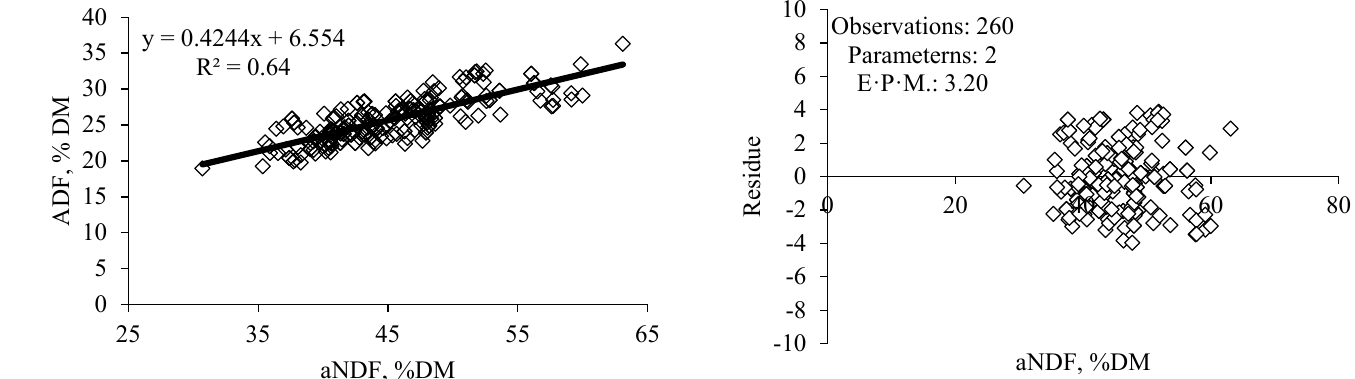
From the analysis of aNDF and ADF of the sampled silages ( n = 260), we defined an equation for predicting ADF from the aNDF content obtained, being: y = 0.4244x + 6.554, where the coefficient of determination (R 2 ) was 0.64 (Figure 5).